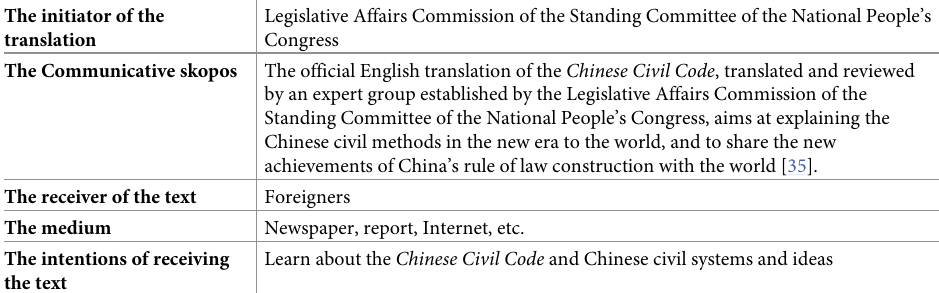
Table 1. Information based on Skopos